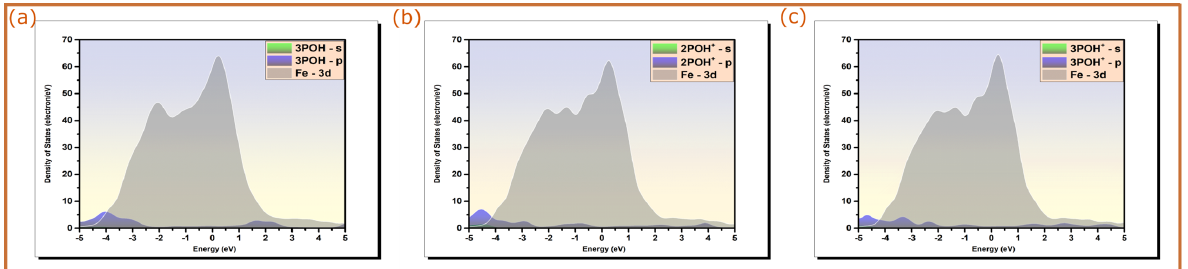
Figure 4. Projected density of states of pyridine molecules adsorbed on Fe(110) surface; ( a ) 3POH, ( b ) 2POH + , and ( c ) 3POH + . Fermi energy (EF) is chosen as the zero energy level.